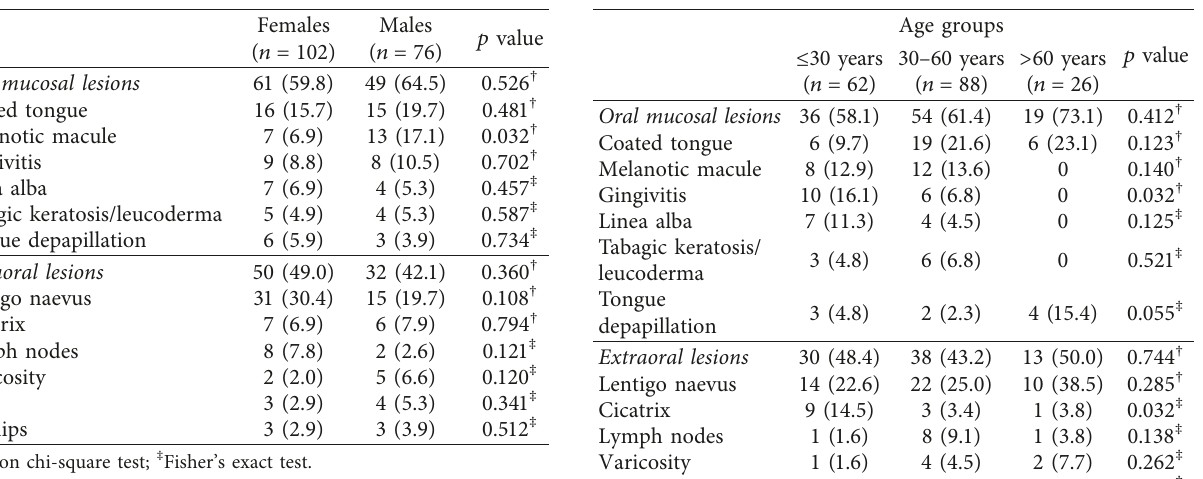
Table 5: Most frequent extraoral and oral mucosal lesions by sex categories.